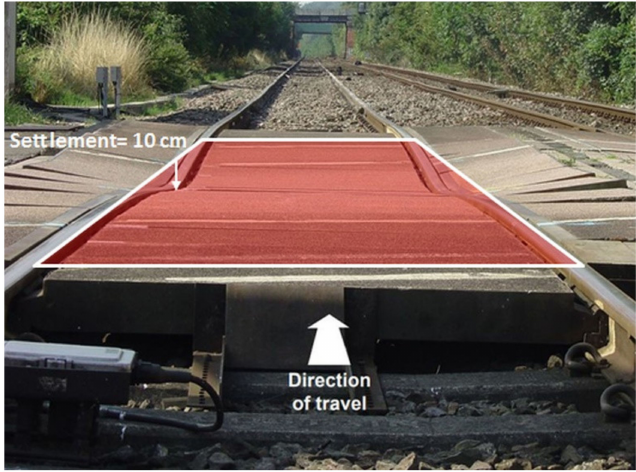
Figure 2. Track settlement at the place of accident